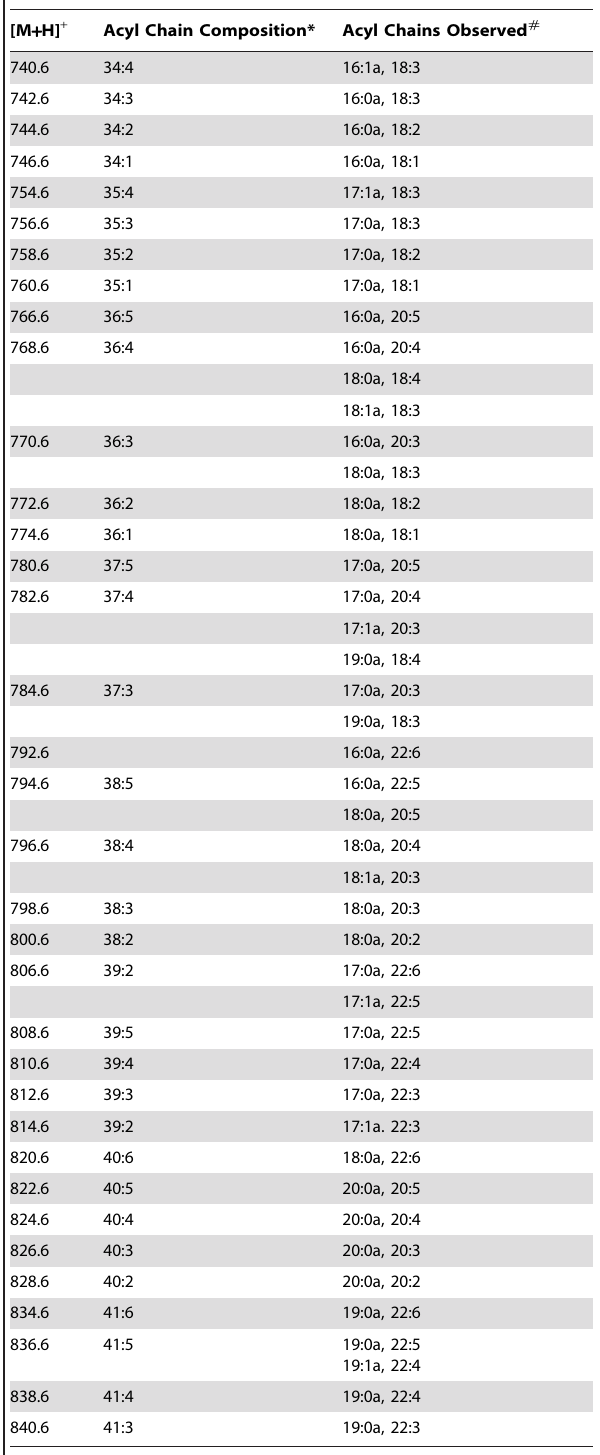
[32]. The loss of the phosphocholine head group yields a minor product ion at m/z 599.504. The product ions at m/z 500.308, 482.357, and 464.347 correspond to loss of acyl chains as either a ketene ( m/z 500 and 464) or a free acid ( m/z 482). Further MS/